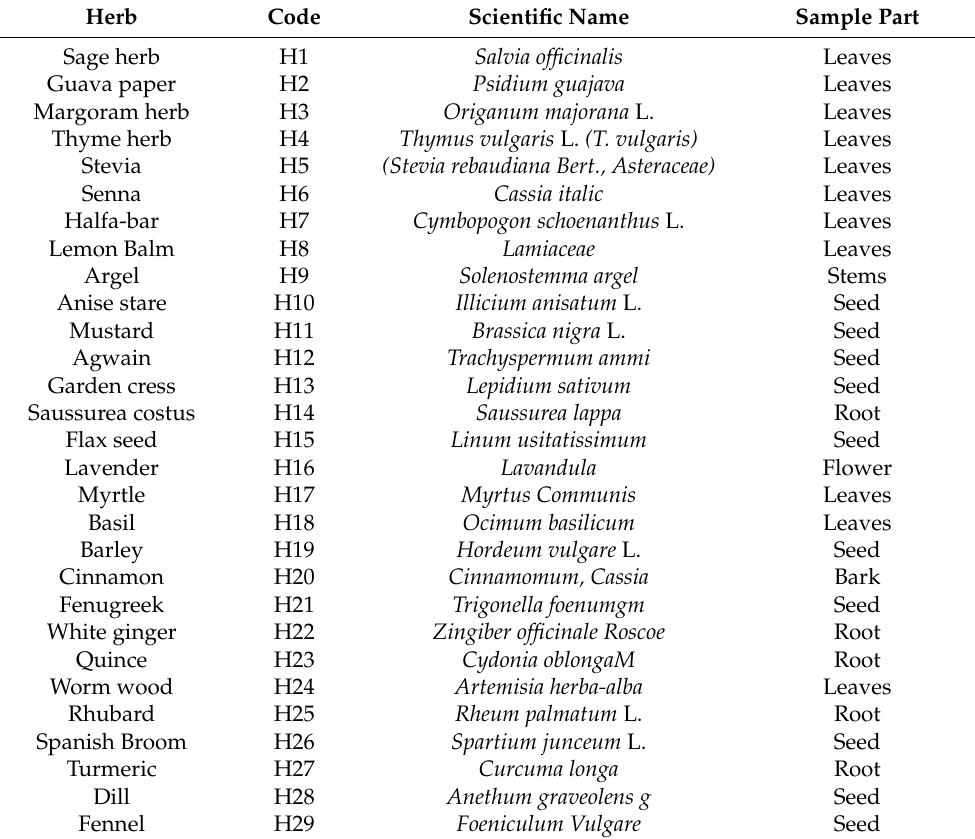
Table 1. Physical data of